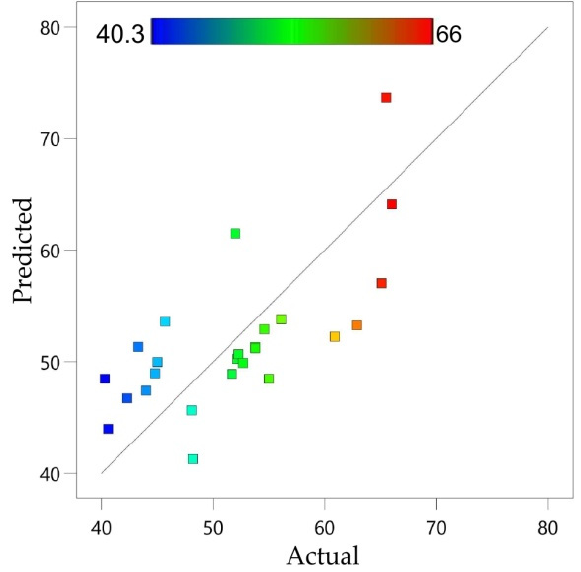
Figure 11. Predicted versus actual response for maximum formable wall angle (units in °).